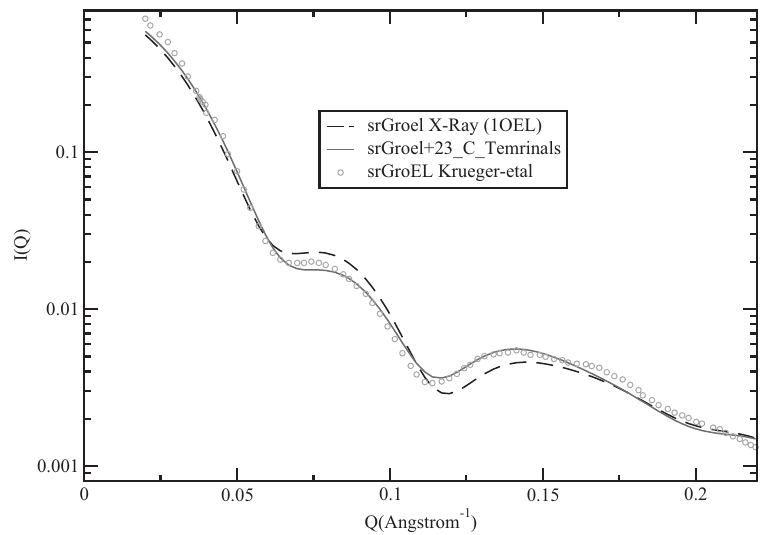
Figure 3. Validity test of the full atomistic run. The plot shows the experimental scattering intensity of solution of single ring GroEL obtained with SANS (o). Fitted over the data with the program Cryson [12], we plotted the scattering intensity of the MD equilibrated structure (___) and of the X-Ray structure obtained by Brag et al. [26] (- - -). The fit of the simulated data is significantly better than the one from the X-Ray structure indicating that the representation of the C-Terminal chains is